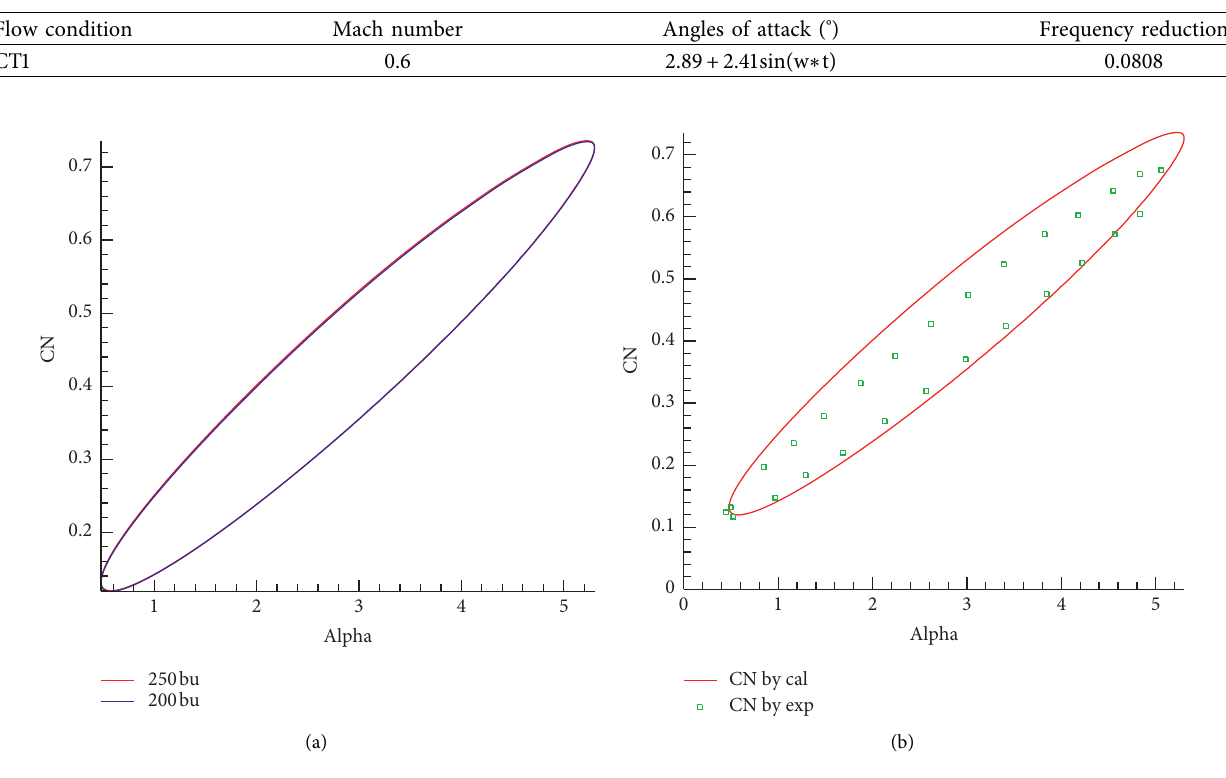
Table 3: Unsteady computational